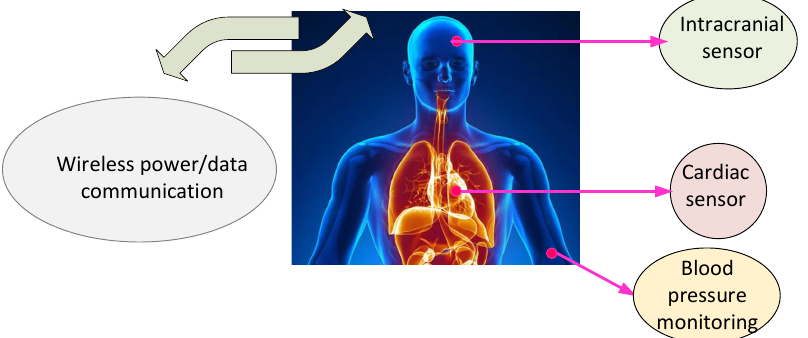
Figure 30. General view of wireless implantable sensors.